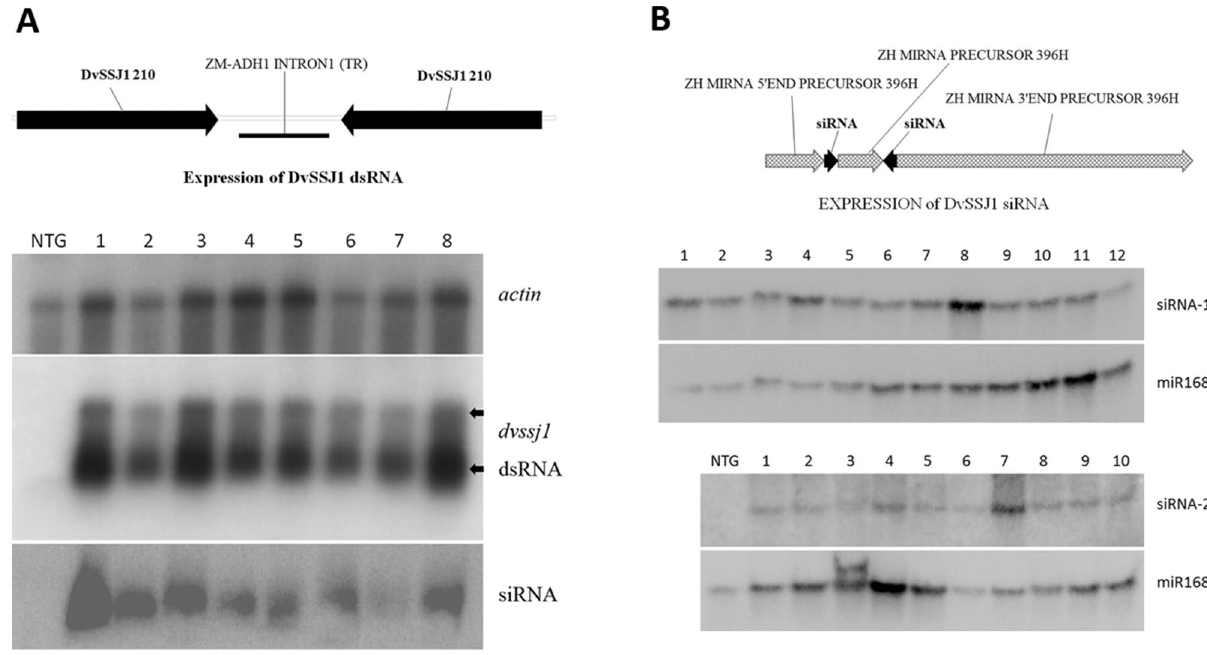
Figure 4. Northern blot analyses of T0 DvSSJ1 root samples. ( A ) Northern blots of eight DvSSJ1 dsRNA events and a non-transgenic control (NTC). A top diagram illustrates the dsRNA expression cassette. Zm-actin (Accession #: EU952376) was included as a reference gene for northern analysis (top panel). Plants containing 210 bp DvSSJ1 cassette expressed both long dsRNA transcripts (middle panel) and siRNAs (bottom